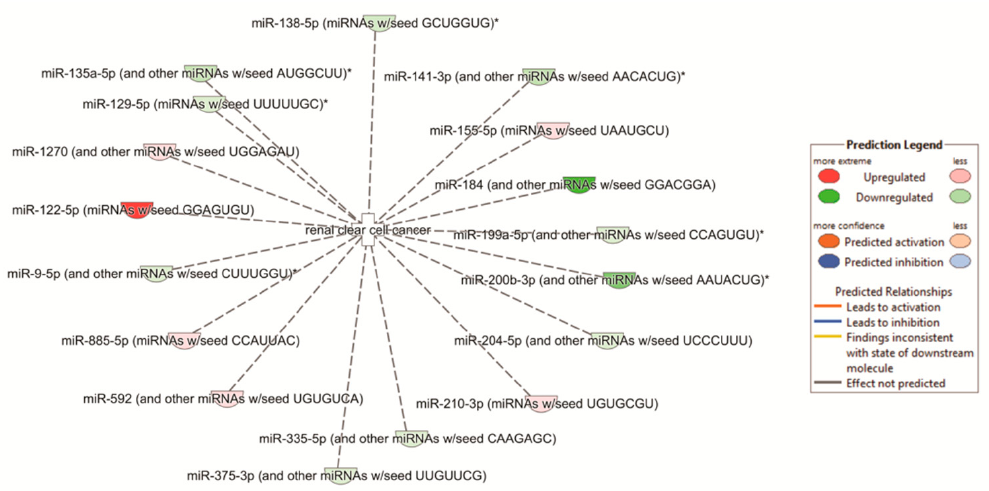
Figure A2. A visual representation of the “renal clear cell cancer” network and how our data relates to this. The p -value was 2.84 × 10 − 4 .